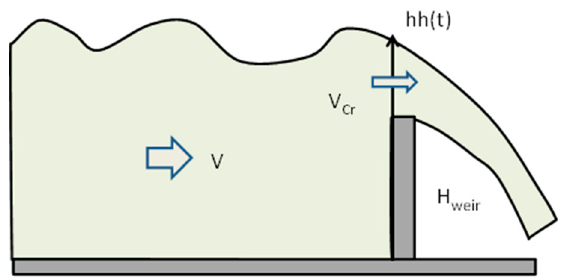
Figure 12 : Weir outflow Figure 12. Weir